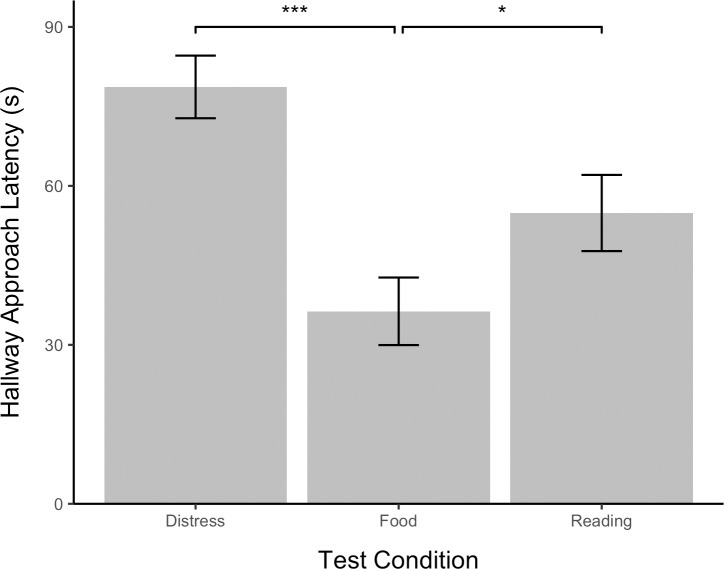
Latency to approach hallway by test condition.Error bars show standard errors.